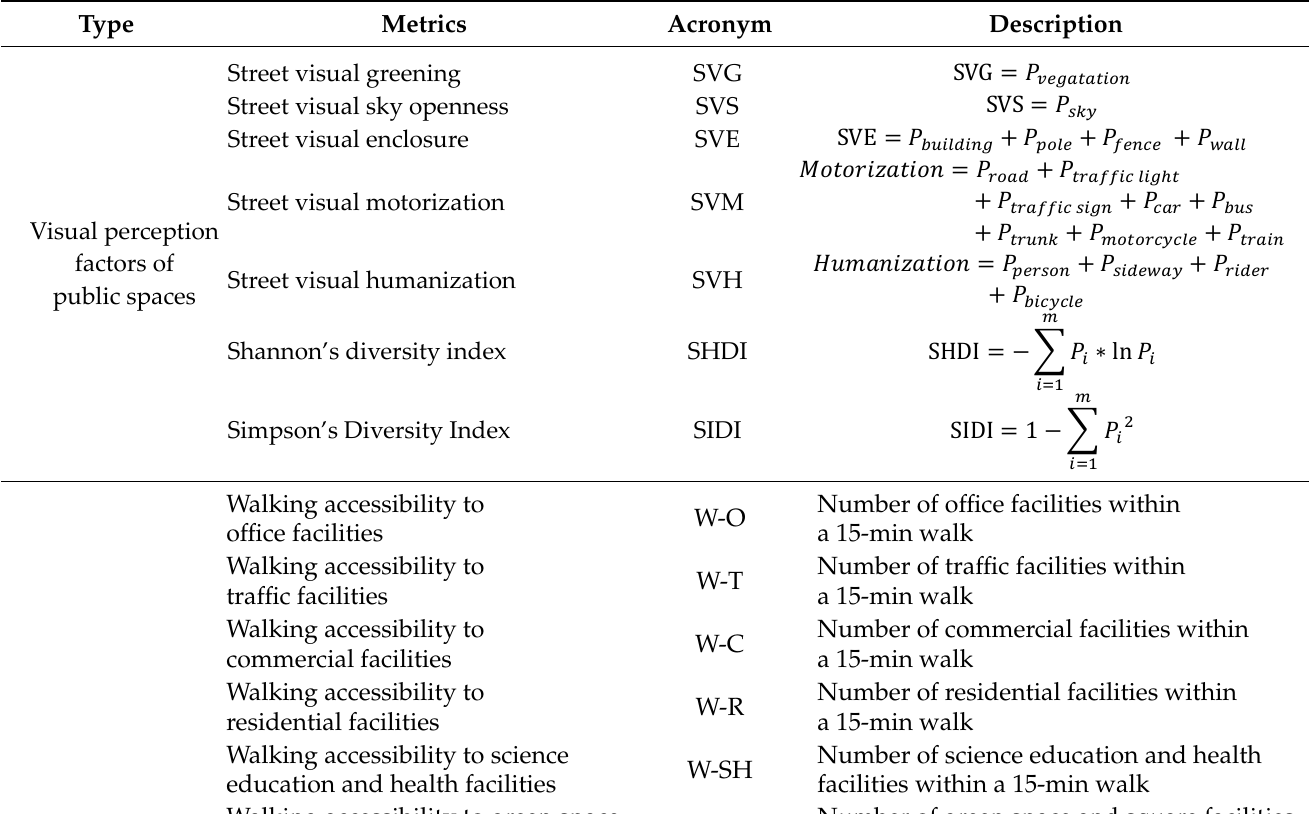
Table 1. Basic information of human perception factors analyzed in this study.